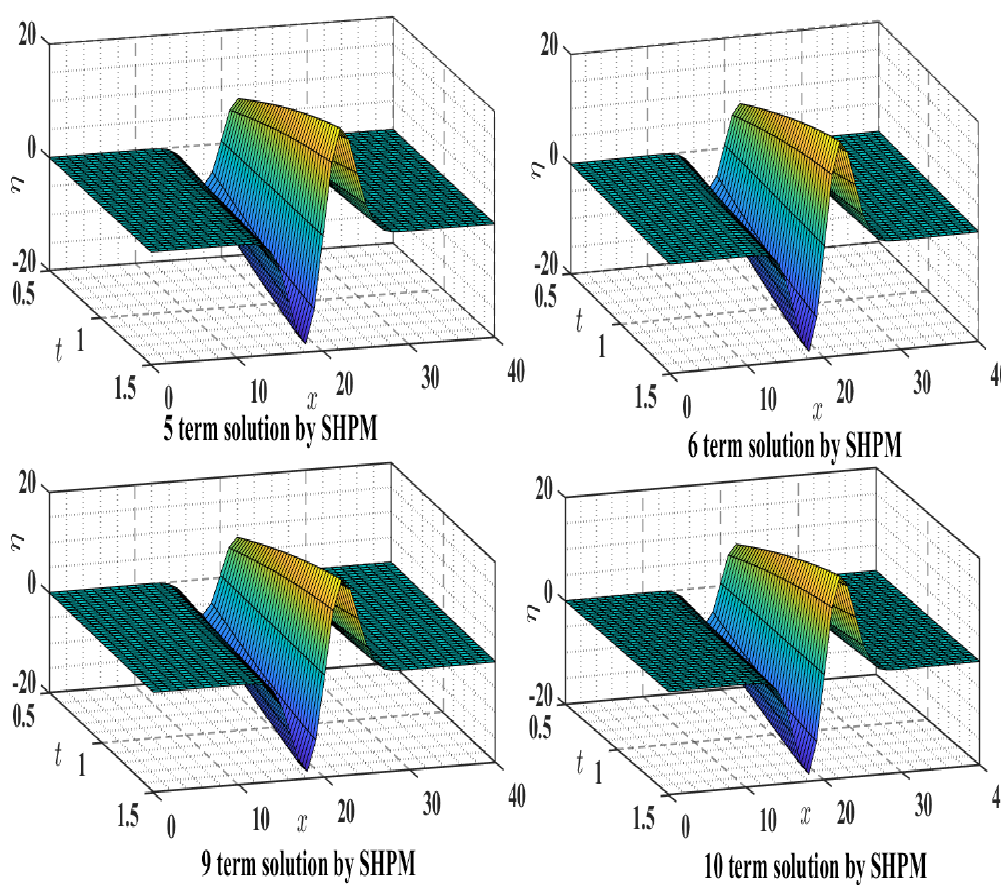
Figure 2. Term-wise solution obtained by SHPM.